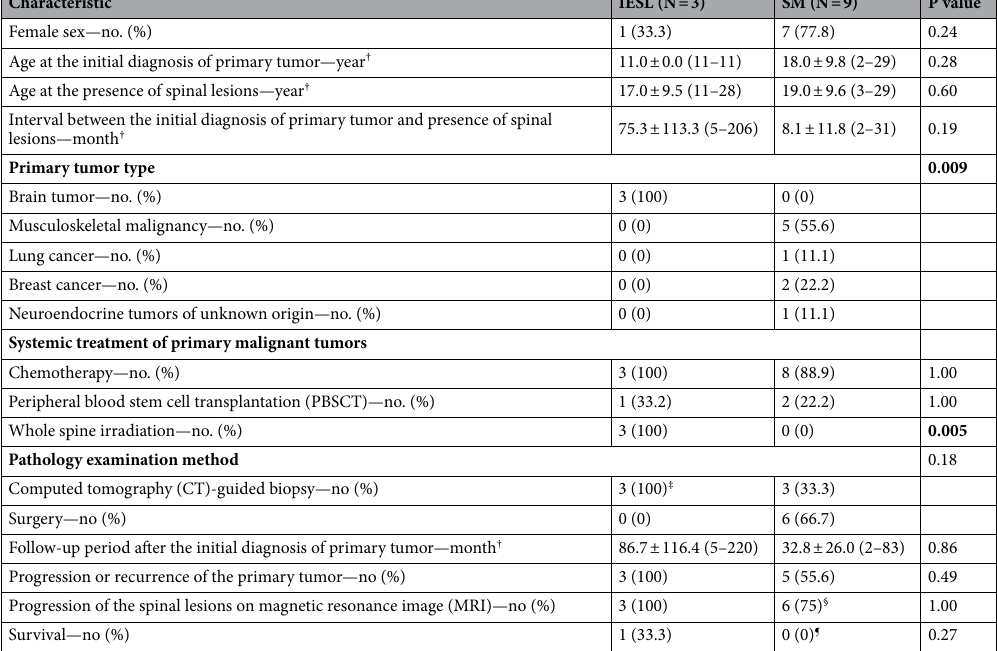
Table 1. Demographic characteristics of the 12 patients with enhancing spinal lesions on MRI. * IESL indolent enhancing spinal lesions, SM spinal metastasis. † Data are expressed as the mean ± standard deviation (range). ‡ One patient had undergone CT-guided biopsy twice, both of which identically disclosed IESLs. § One